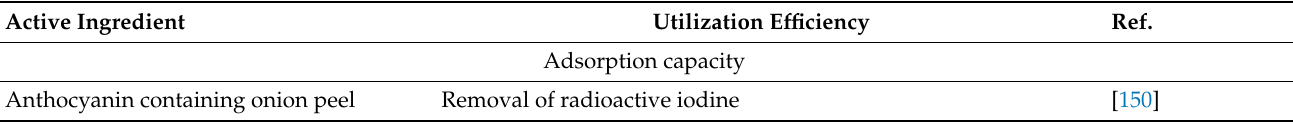
Figure 14. Exocarp/mesocarp differences in minerals accumulation. (* values are halved).